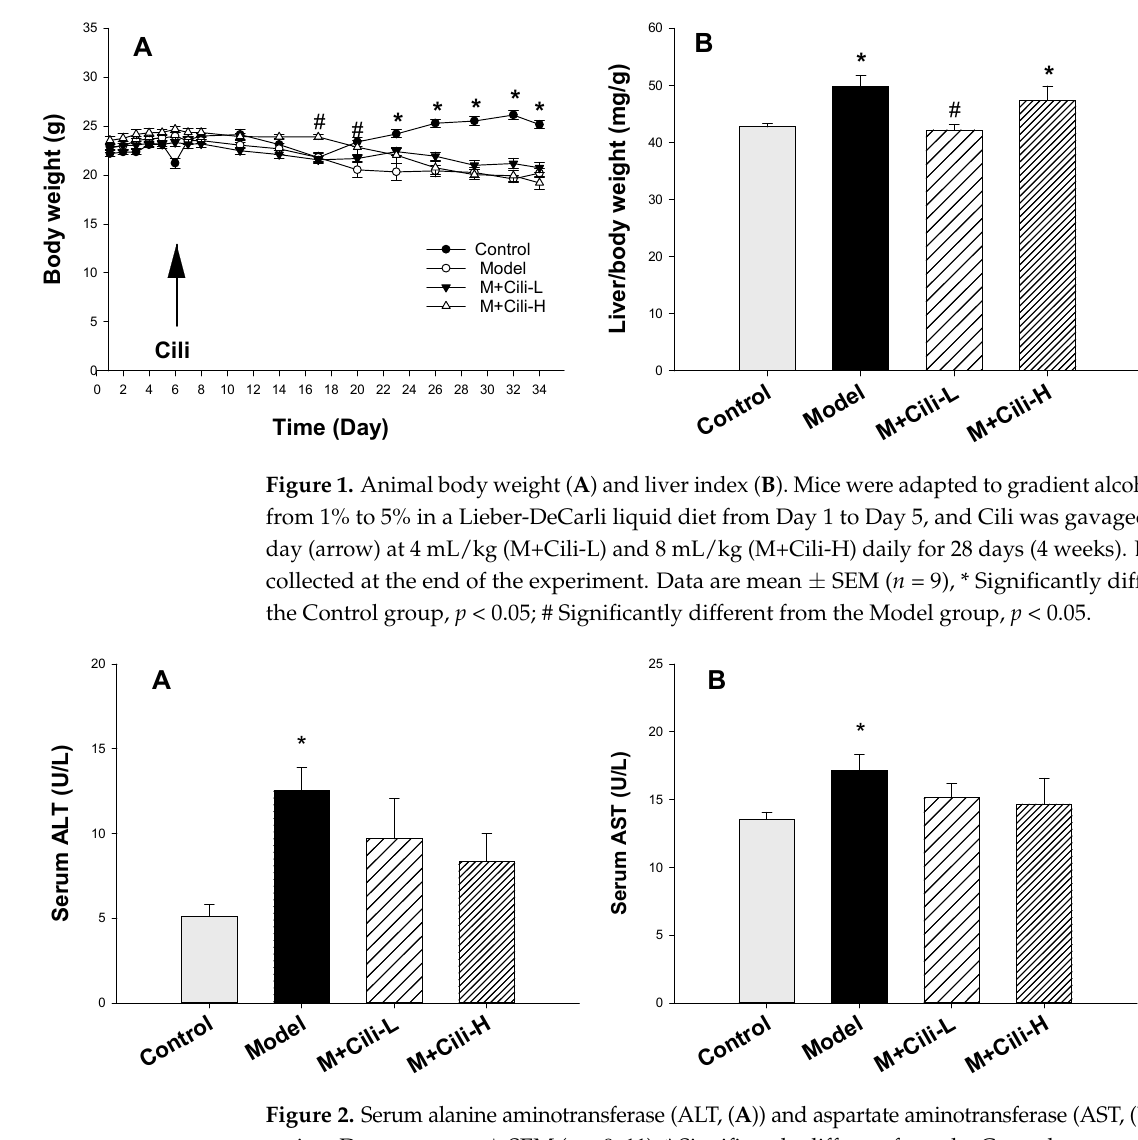
Figure 2. Serum alanine aminotransferase (ALT, ( A )) and aspartate aminotransferase (AST, ( B )) determination. Data are mean ± SEM ( n = 9–11), * Significantly different from the Control group, p < 0.05.